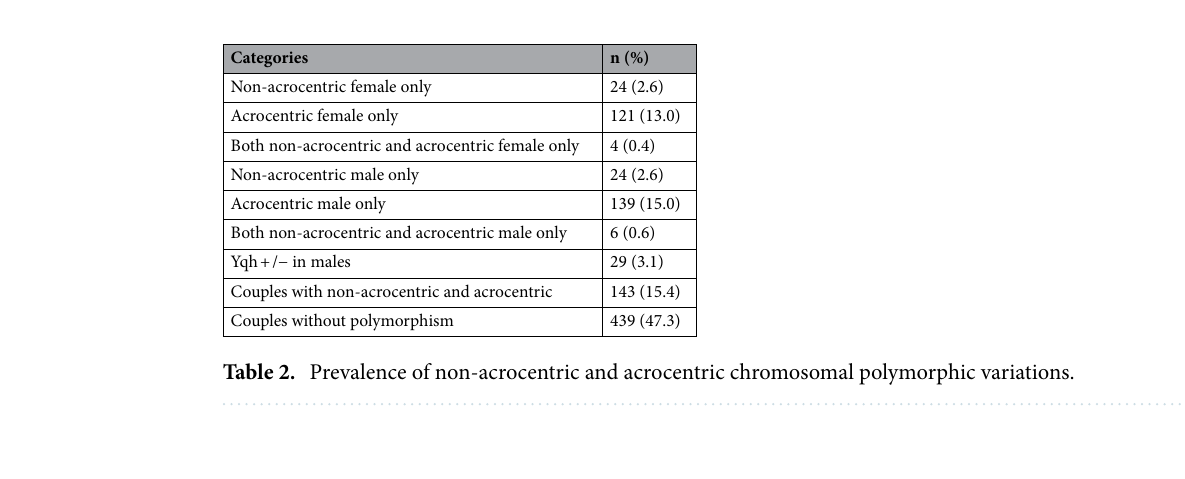
Chromosomal polymorphic